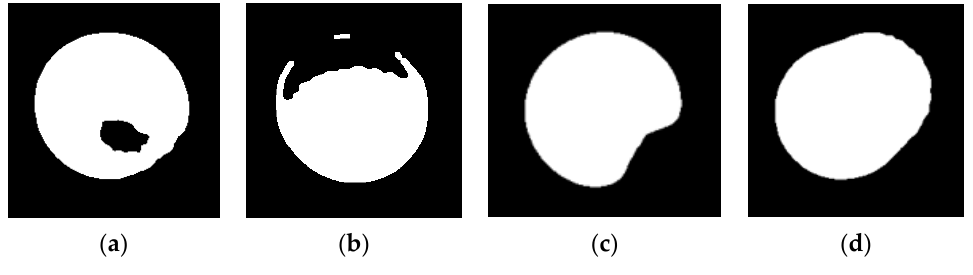
Figure 18. Examples of “light shadow error”.